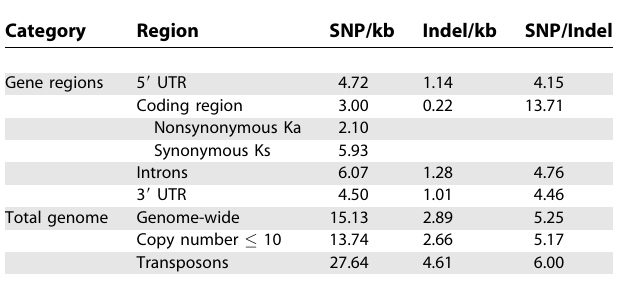
Table 5. Variation between indica and japonica Defined by SNP and Insertion–Deletion (Indel) Rates